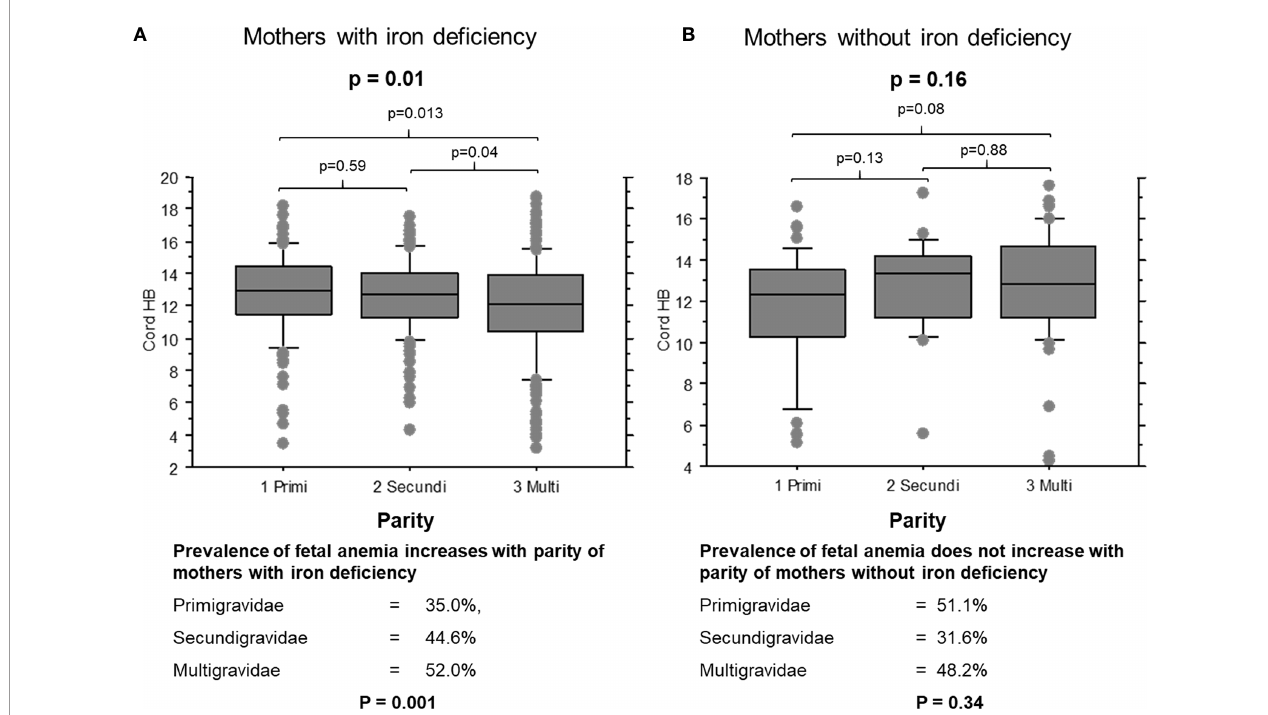
FIGURE 1 | Cord blood hemoglobin levels in offspring of mothers with and without iron de fi ciency, strati fi ed by parity. (A) Cord samples from mothers with iron de fi ciency: 1, primigravidae (n = 53); 2, secundigravidae (n = 72); 3, multigravidae (n = 132). (B) Cord samples from mothers with normal iron status: 1, primigravidae (n = 29); 2, secundigravidae (n = 14); 3, multigravidae (n = 31). The box plots indicate the median (horizontal line) and interquartile range (box), and the whiskers represent 10 th /90 th percentiles. The differences between groups were analyzed by the Kruskal-Wallis test. Associated P values are shown.